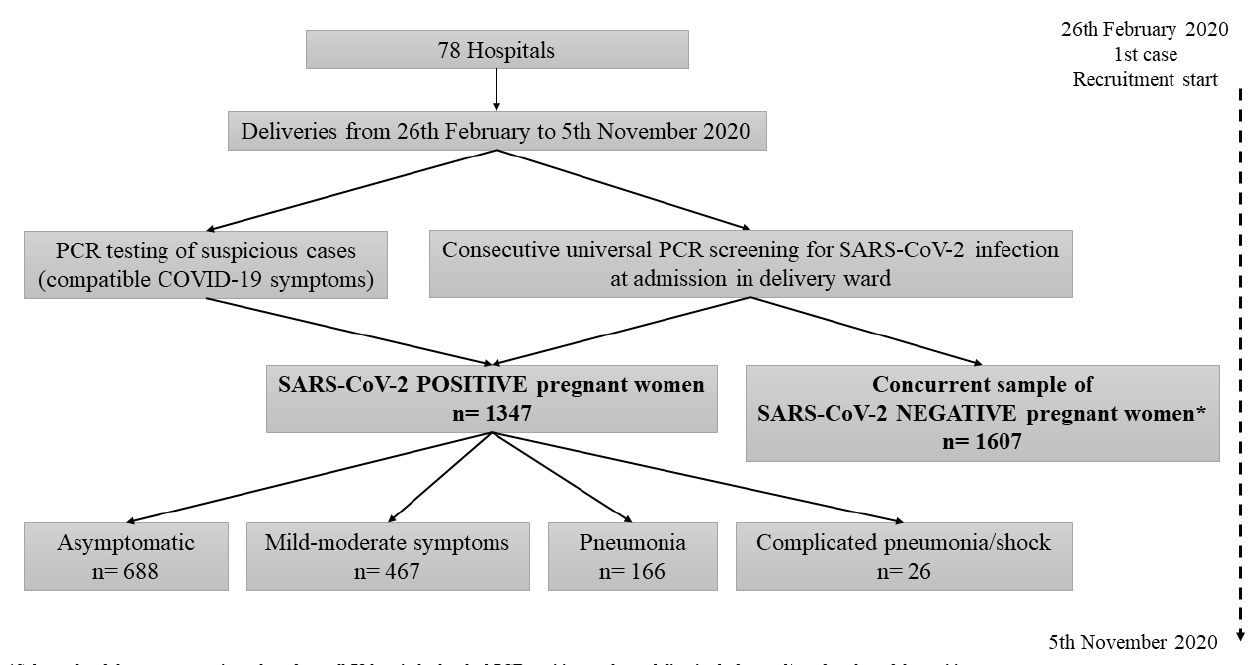
Figure 1. Flow chart of the study data.